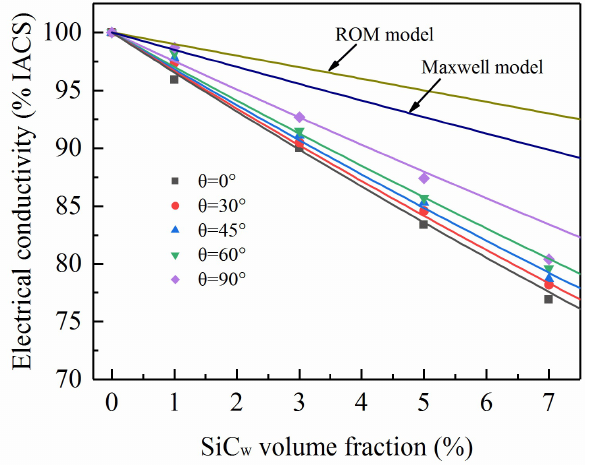
Figure 9: The electrical conductivity of composites with different SiC whiskers orientation angles was calculated and compared with experimental